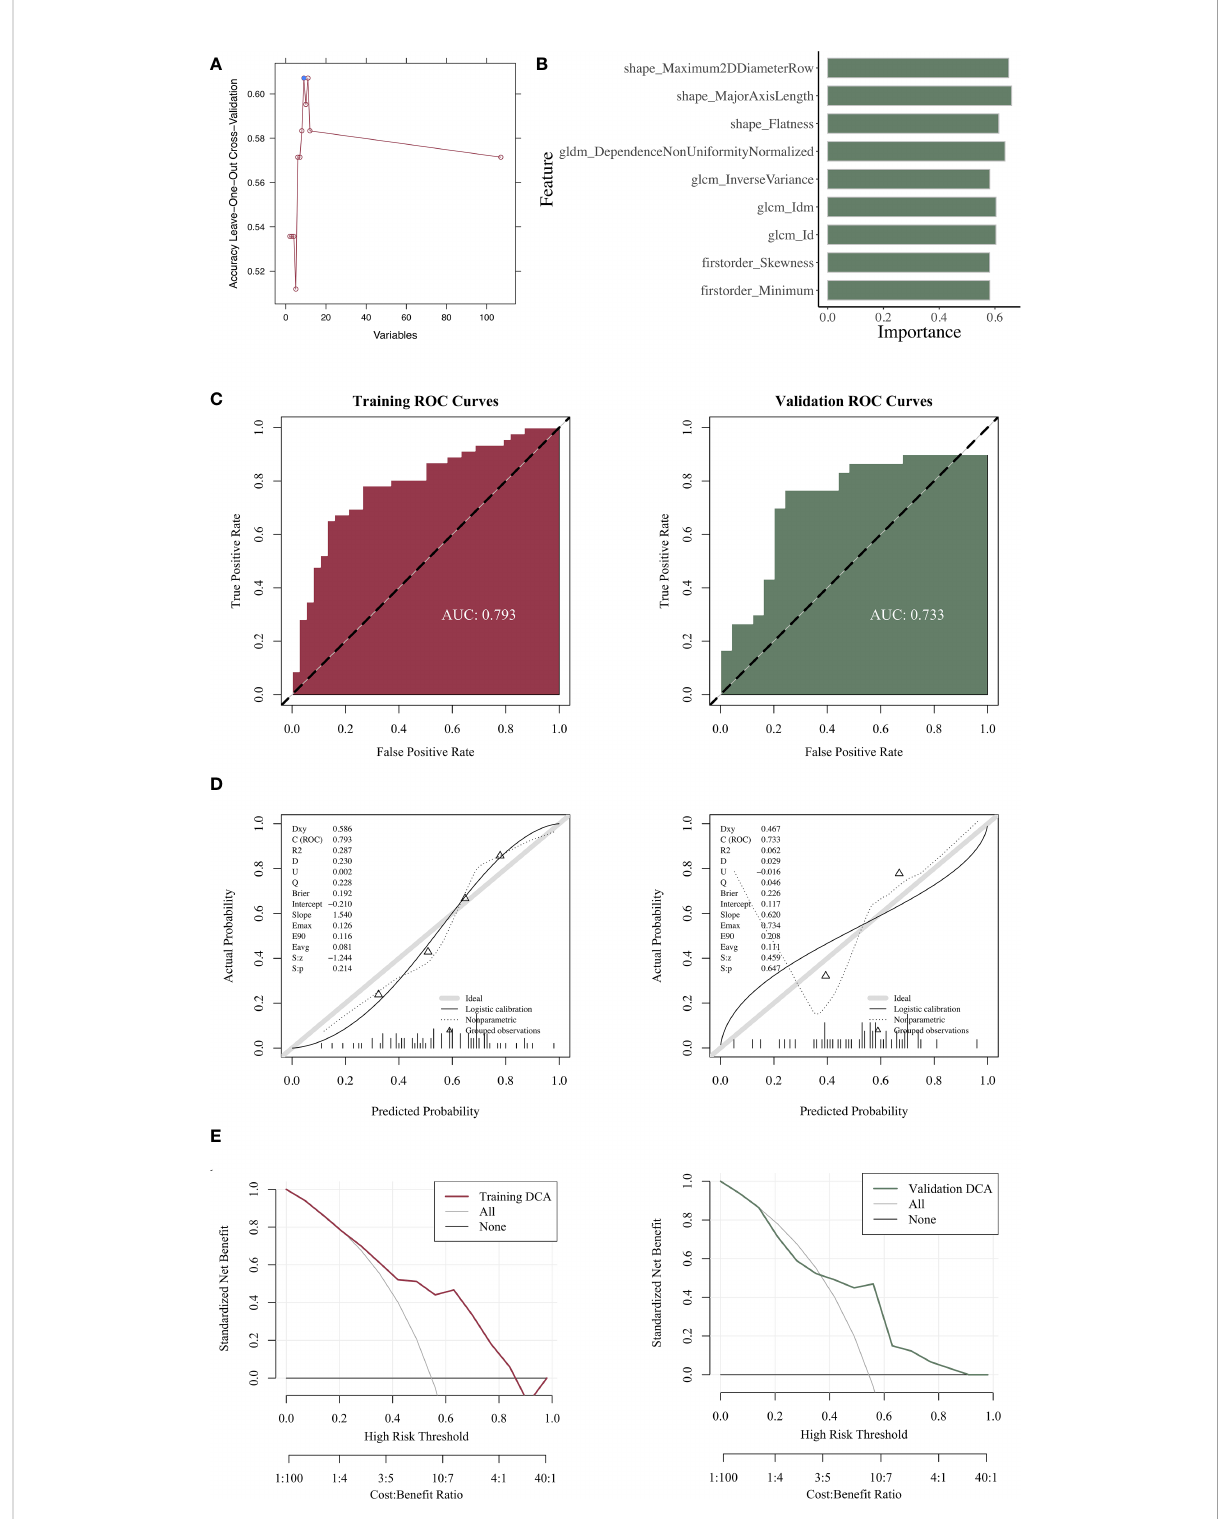
FIGURE 3 Construction and evaluation of the radiomics models. (A) Radiomics features with statistical differences. (B) Importance of the selected features in the model. (C) ROC curve analysis of the radiomics model. (D) Calibration-curve analysis of the radiomics model. (E) Hosmer – Lemeshow goodness-of- fi t testing of the radiomics